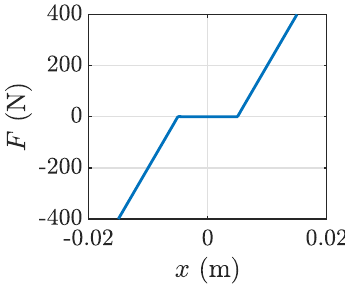
Figure 2. Nonlinear force-displacement dependency.